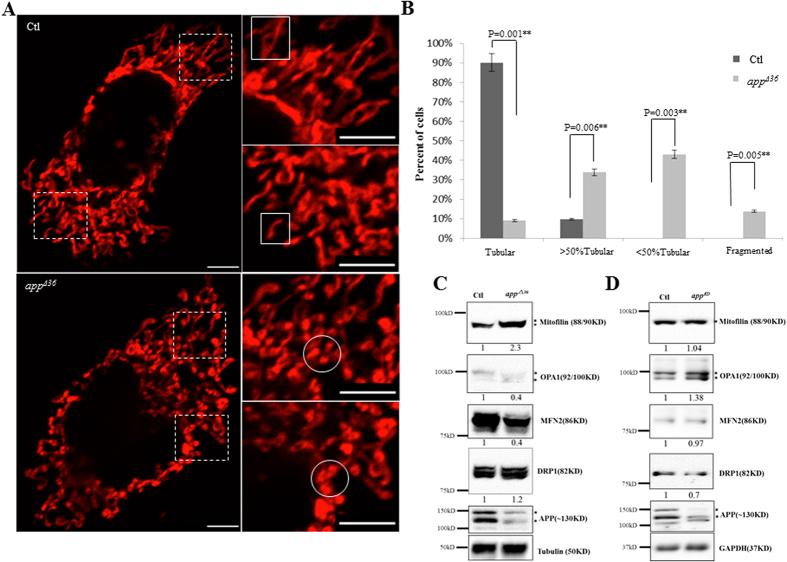
Mitochondrial morphology is altered in appΔ36 cells.(A) Effect of mutant APP on mitochondrial morphology. Images were acquired with 100× oil-immersion objective. The images in the dotted box are shown at a higher resolution on the right (scale bar 10 μm). The normal tubular morphology of isolated mitochondria is indicated with the white box; spherical or elliptical mitochondrial with higher fluorescent intensity are indicated with circles. (B) Quantitative analysis of mitochondrial morphology. All images were acquired under same conditions without any processing. The mitochondrial morphology of 100 cells per genotype was scored visually from three independent experiments according to the indicated criteria. The aspect ratio (RA) of isolated tubular mitochondria was more than 2. A mitochondrial RA of less than 2 was considered to be spherical or elliptical mitochondrial fragments. The relative proportion of “tubular” and “spherical fragments” in one cell was the criterion for the mitochondrial morphology analysis. For the “tubular” group, only tubular mitochondria were found in the cells. “>50% tubular” indicated that more than half of the mitochondrial mass per cell were tubules; “<50% tubular” group indicated that the mass less than half tubules appeared, with at least 3 clearly tubular mitochondria; “fragmented” indicated cells containing spherical mitochondrial fragments with a maximum of 2 short tubules. Error bars represent the mean ± SEM. Statistically significant differences are indicated with asterisks (*P < 0.05 versus control, **P < 0.01 versus control). Mitochondrial fusion factors MFN2 and OPA1 are decreased in appΔ36 cells (C) but not in appKD cells (D). The immune-reactive proteins with multiple bands are indicated with asterisks.